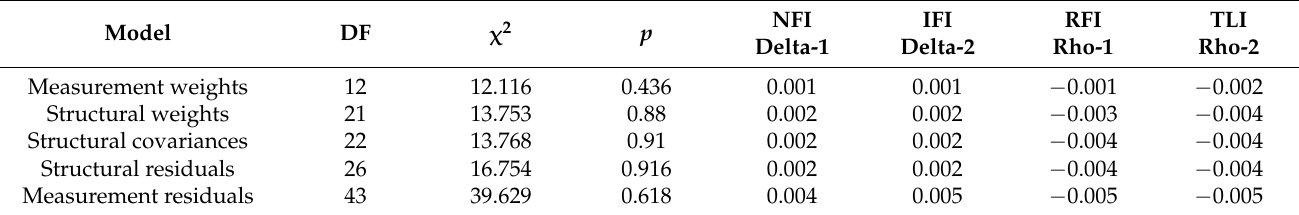
Table 7. Significance of tested models compared to unconstrained model.